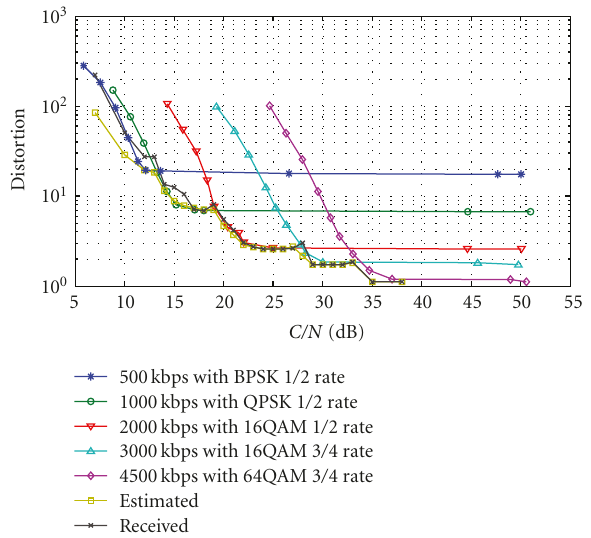
Figure 24: Distortion comparison, table , GOP number 21, initial mode = 3, Set